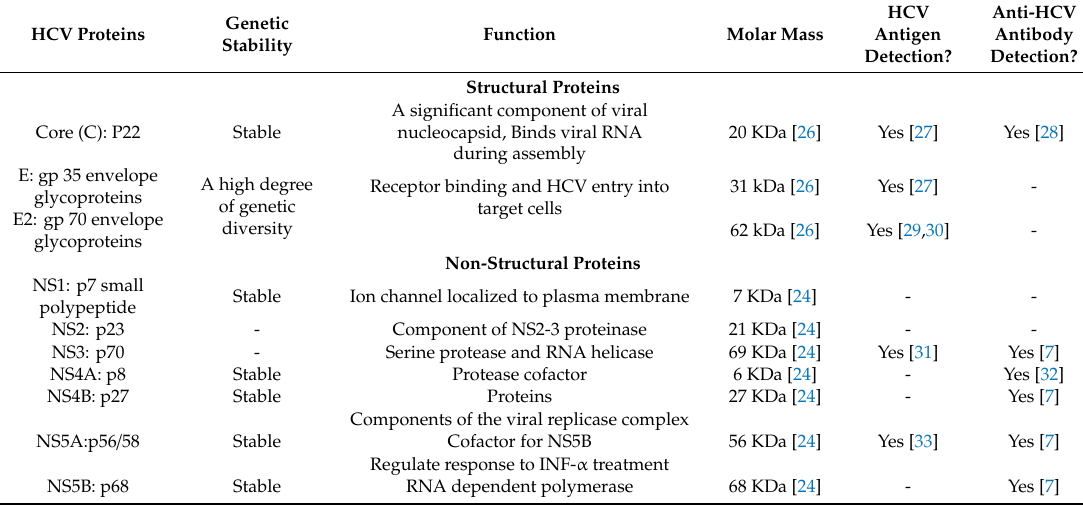
Figure 4. Organization of HCV genome ( top ) and the ten di ff erent sections of a polyprotein that are processed to generate HCV specific proteins ( bottom ). Scissors and arrows indicate cleavages by the peptidase to produce ten proteins with unique functions [24]. Table 1. HCV protein, their functions, molar mass, and their applications in HCV screening by detecting them as antigens or their corresponding antibodies.